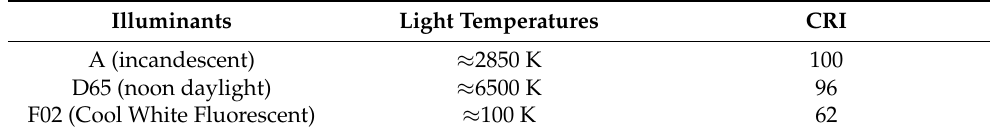
Table 6. Illuminant